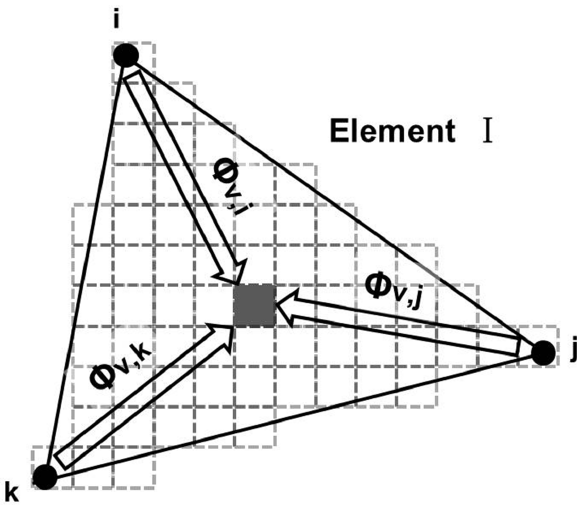
Figure 1: A coupled FE-CA for dendritic growth